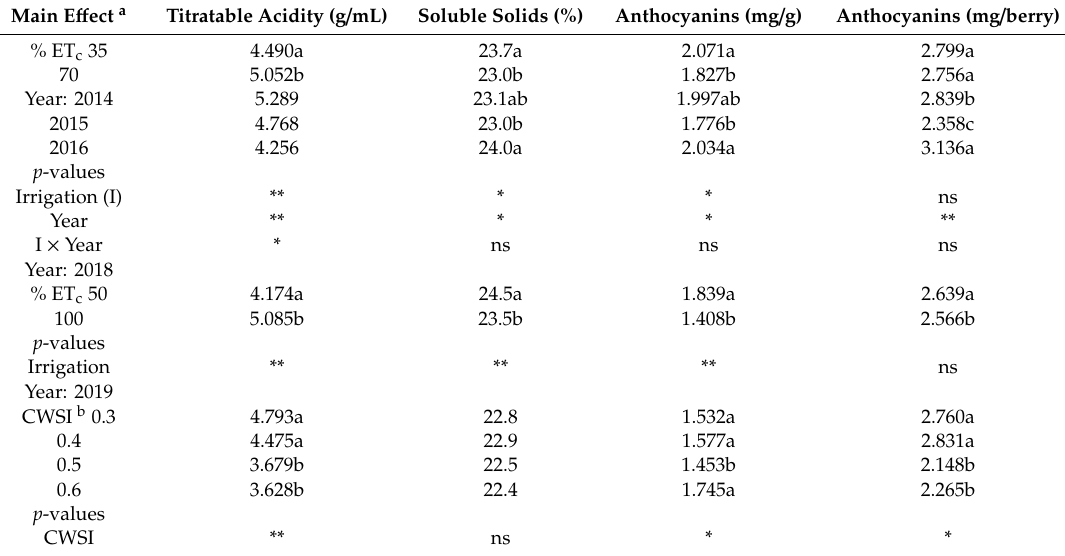
Table 4. Berry attributes of Malbec grapevines grown under semi-arid conditions in southern Idaho that were drip-irrigated at weekly intervals with di ff ering fractions of estimated water demand (ET c ) (2014, 2015, 2016, 2018) or irrigated with the same amount of water at di ff ering irrigation intervals (2019) based upon threshold daily crop water stress index ( CWSI )